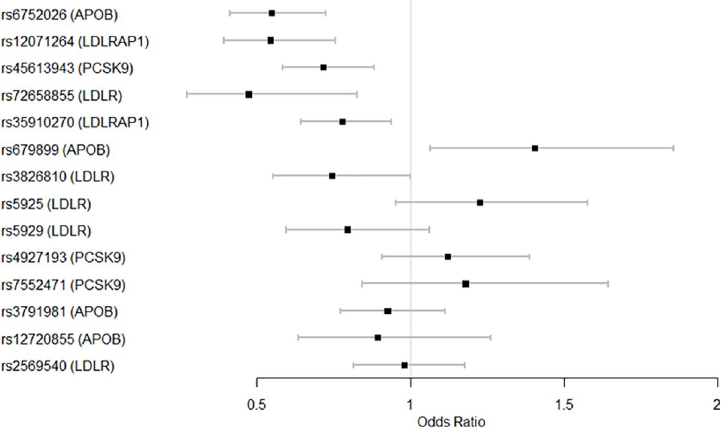
Fig 1. Logistic regression of the 14 selected gene variants associated with LDL-cholesterol levels. The plot shows the odds ratio (OR) for variants after adjusting for covariates (sex and geographic region). Bars represent 95% confidence interval (CI). When OR < 1, the minor alleles are associated with low LDL-cholesterol levels. Only one variant is significantly associated with high LDL-cholesterol levels (rs679899) with a significant OR > 1.